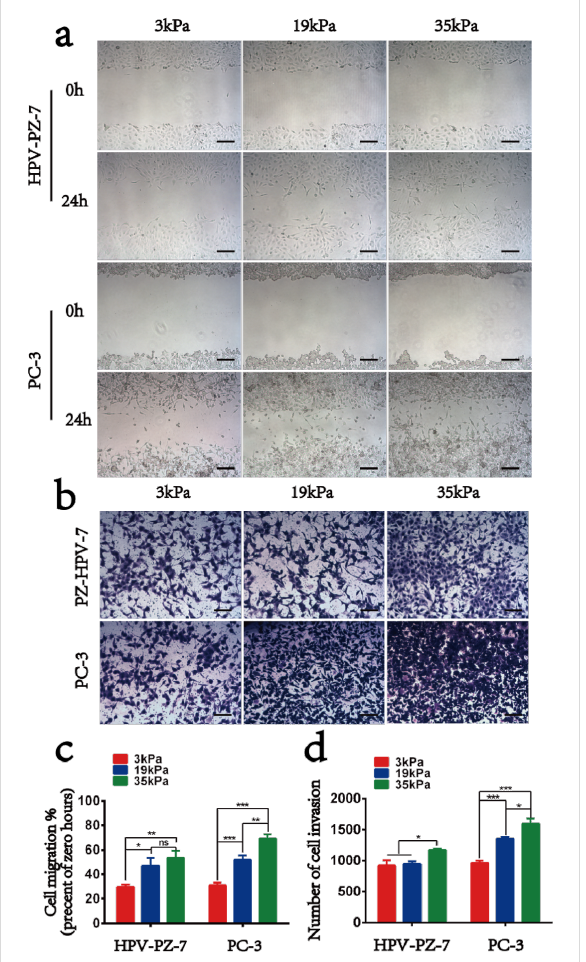
Figure 2: Effect of substrate stiffness on the migration of HPV-PZ-7 and PC-3 cells. (a) Analysis of cell wound healing. (b) Transwell analy- sis of the invasion ability. (c) Quantitative evaluation of the migration ability. (d) Quantitative evaluation of the invasion ability. Scale bar = 50 μ m; “ns” means no difference, * represents the value of P < 0.05, ** represents the value of P < 0.01, and *** represents the value of P <